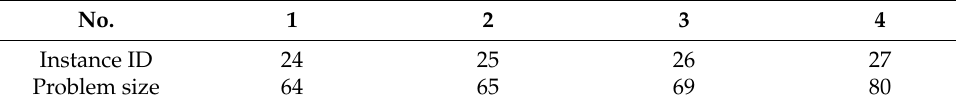
Table 4. Summary of the benchmark Instances 24–27.